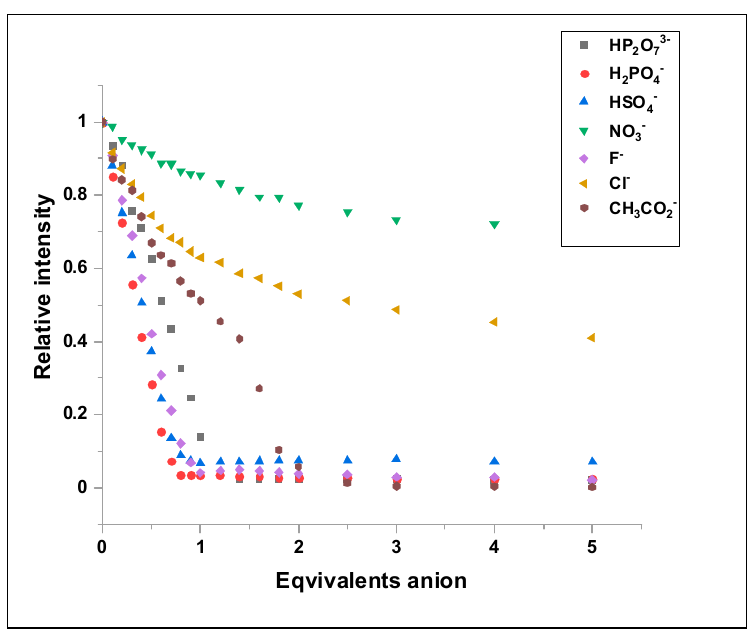
Figure 8. Binding isotherms showing the fluorescence intensity of [Tb. 1] (OTf) 3 at 545 nm vs. equivalents of anion.